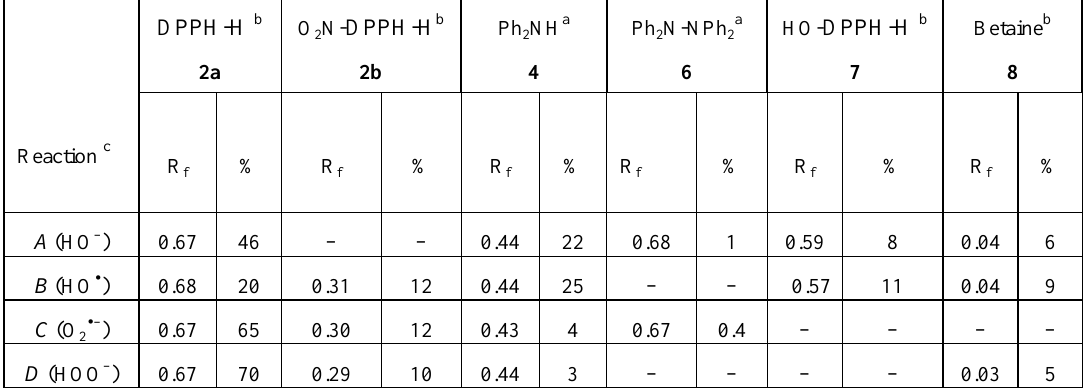
- • •- - , HO , O and HOO in 2